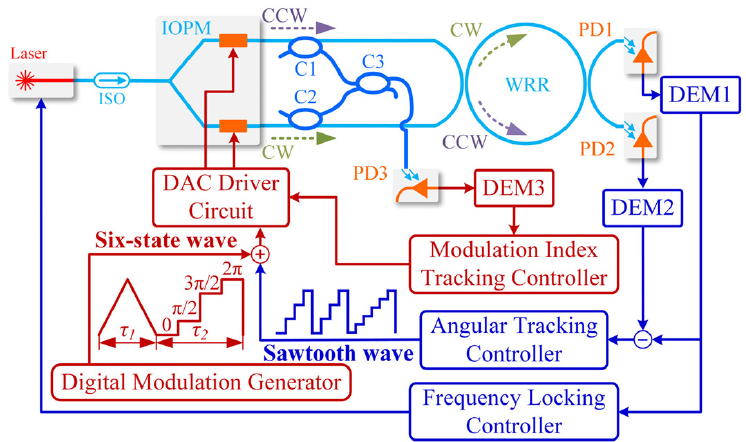
Figure 19. The schematic diagram of RIOG with the modulation index stabilization technique. DEM: demodulator; C1: 99:1 optical coupler; C2: 99:1 optical coupler; C3: 50:50 optical coupler. Reprinted with permission from ref. [90]. Copyright 2019 The Optical Society.